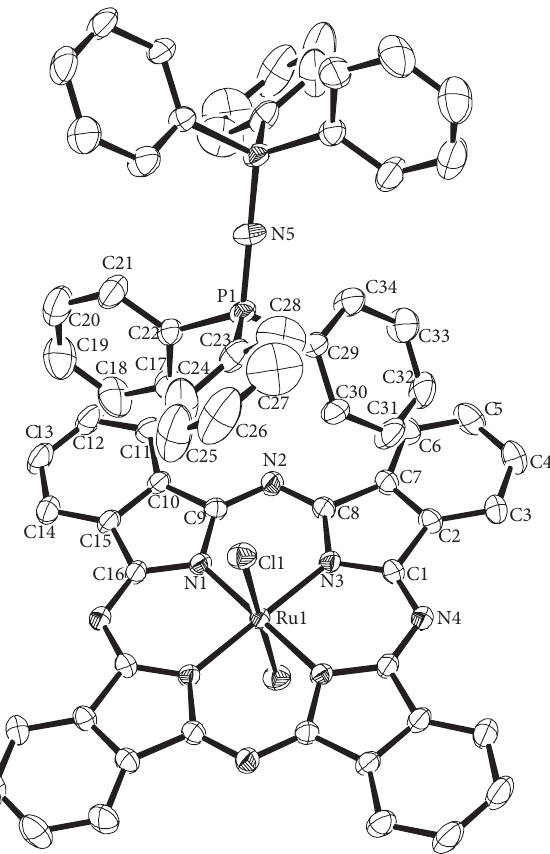
F 2: ORTEP molecular structure representation of PNP[Ru III (Pc)Cl ] (hydrogens are omitted for